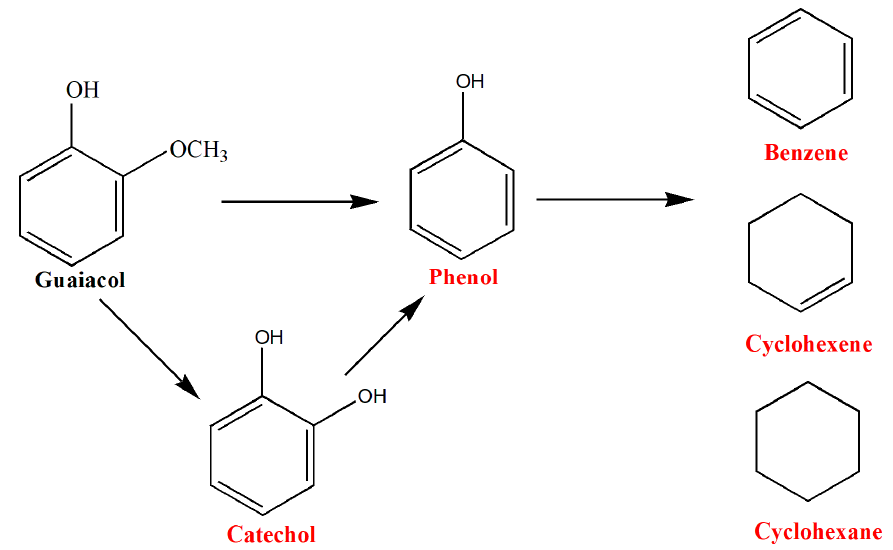
Figure 15. Hydrodeoxygenation (HDO) of guaiacol [214].